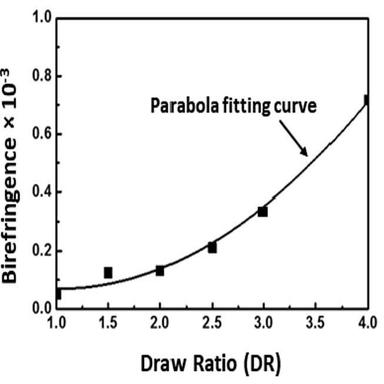
Birefringence value of PCTN film by draw ratio.